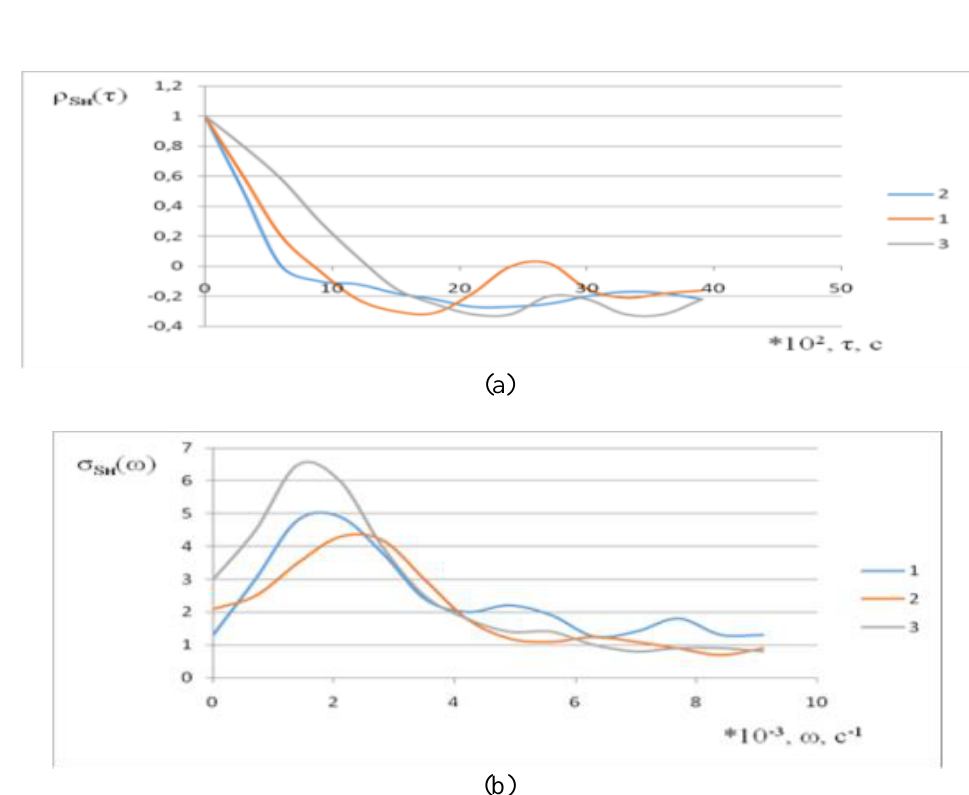
Figure 2. Correlation function (a) and spectral density (b) of the process of changing the initial grain